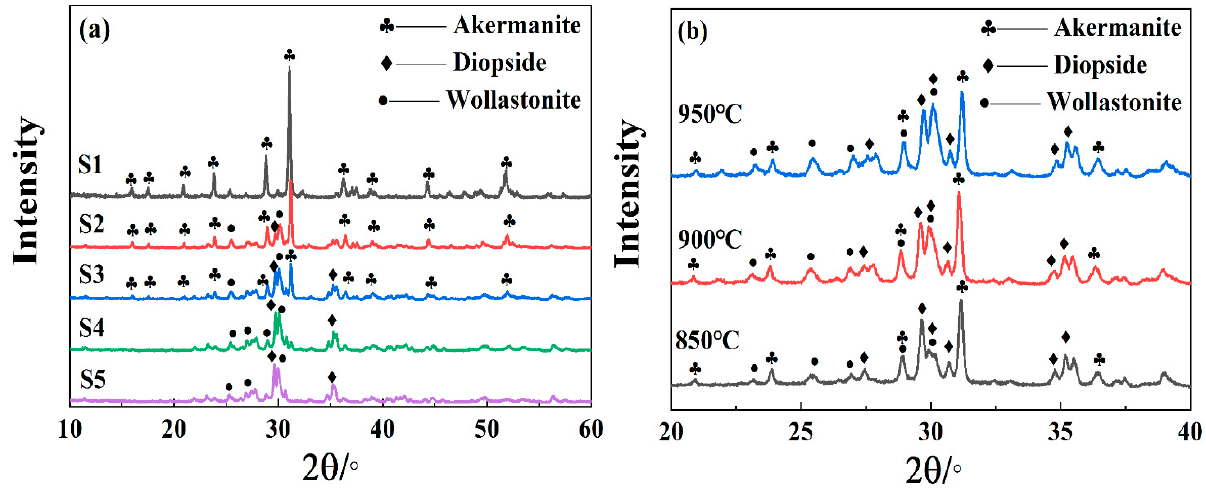
Figure 7. ( a ) XRD patterns of S1–S5 crystallized at 950 °C for 1 h. ( b ) XRD patterns of the S3 heated at different temperatures for 1 h.